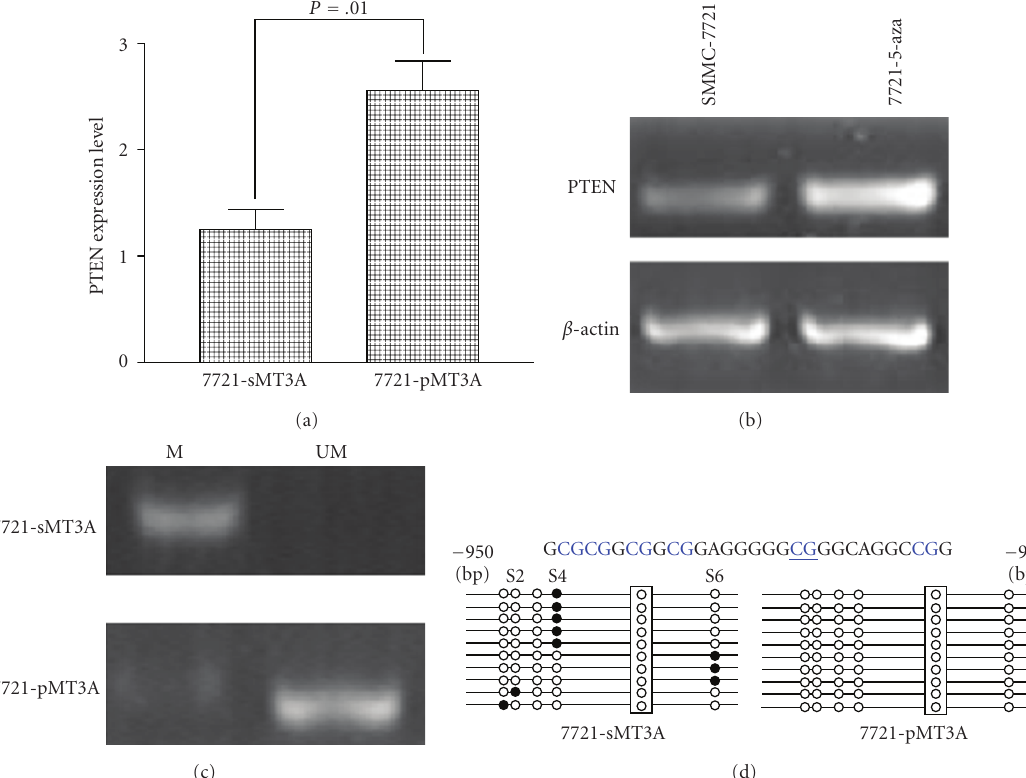
Figure 5: Restoring of PTEN expression by depletion of DNMT3A in HCC cells is partly due to methylation of its promoter. (a) Quantitative- PCR analysis of PTEN expression level in DNMT3A -depleted cell line. (b ) 5-Aza-2 (cid:2) deoxycytidine restored endogenous PTEN mRNA expression in SMMC-7721 cells. (c) Methylated status evaluation of PTEN promoter region determined by MSP. The presence of visible PCR product in lanes marked “U” indicates the unmethylated gene, whereas the presence of product in lanes marked “M” indicates the methylated gene. (d ) Bisulfite sequencing of the selected region of the PTEN promoter in DNMT3A -depleted SMMC-7721 cells. Top, sequences within the fragment include 6 CpG sites (S1, S2, S3, S4, S5, S6). Bottom, the methylation pattern of 6 CpG sites in PTEN promoter region is shown. Ten random clones from DNMT3A -depleted SMMC-7721cell line and control were sequenced to examine the methylated status. Open and closed circles indicate unmethylated and methylated sites,